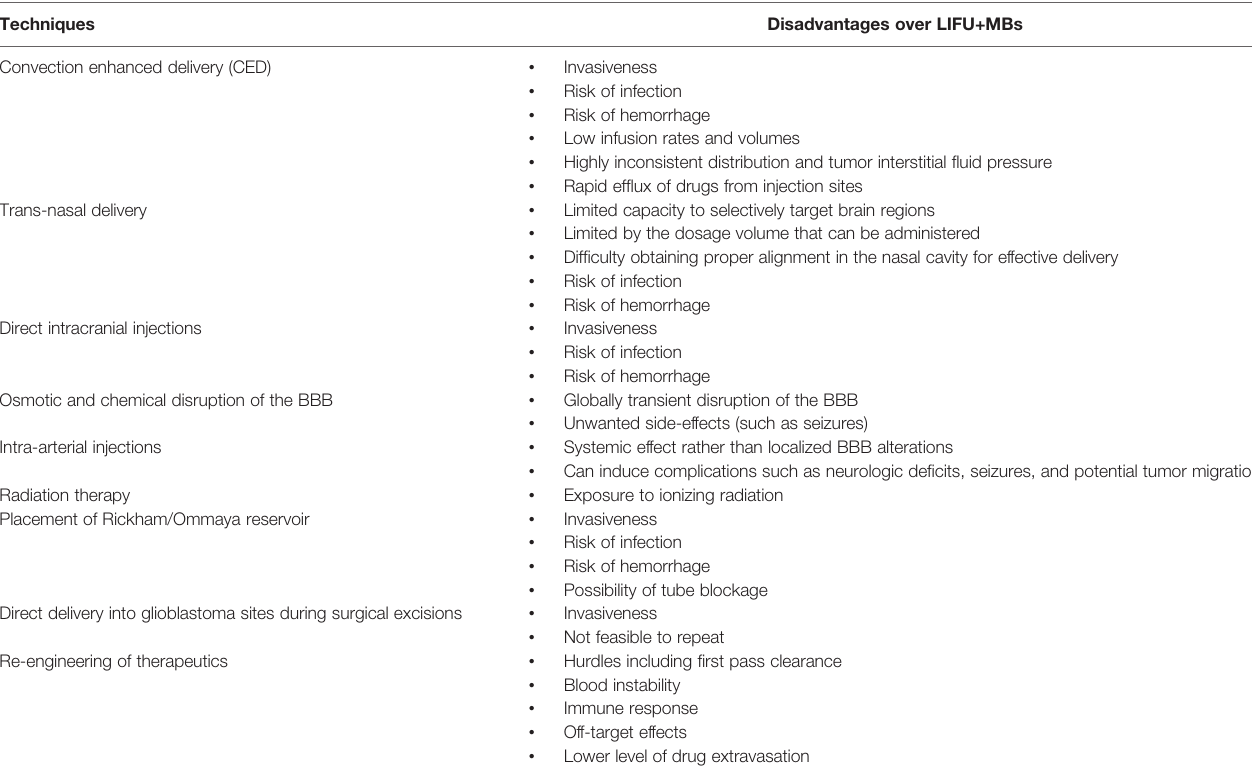
TABLE 1 | Current techniques to overcome BBB/BTB and their drawbacks over LIFU+MBs. Techniques Convection enhanced delivery